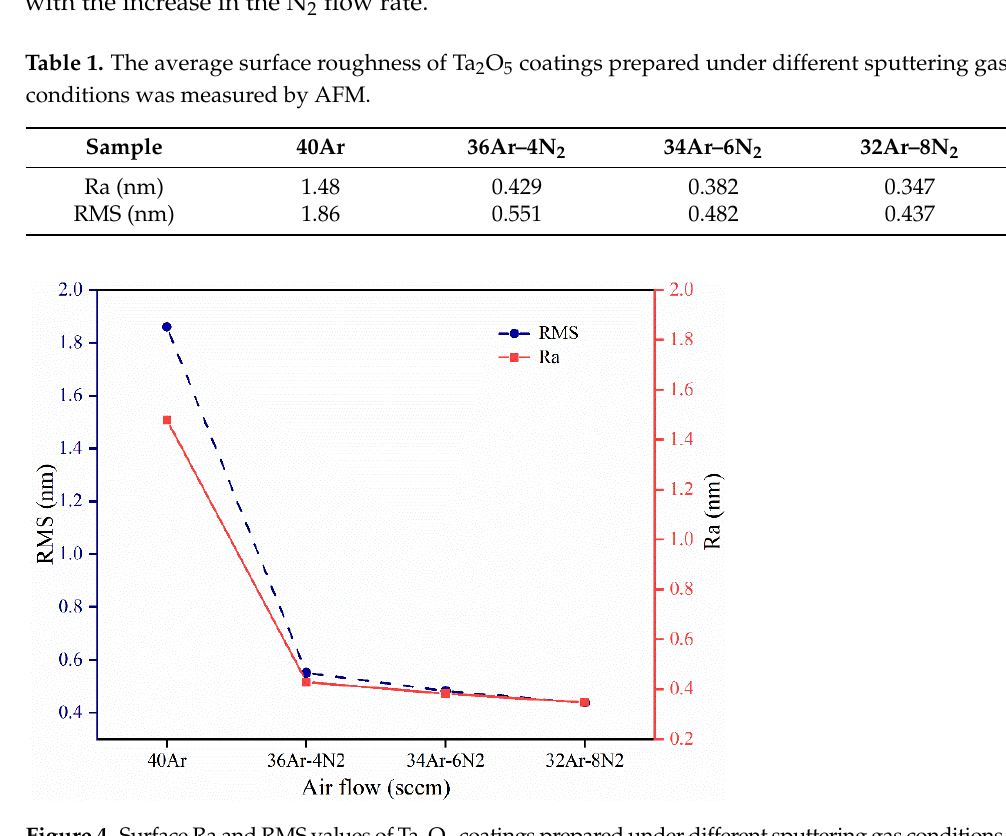
Figure 4. Surface Ra and RMS values of Ta 2 O 5 coatings prepared under different sputtering gas